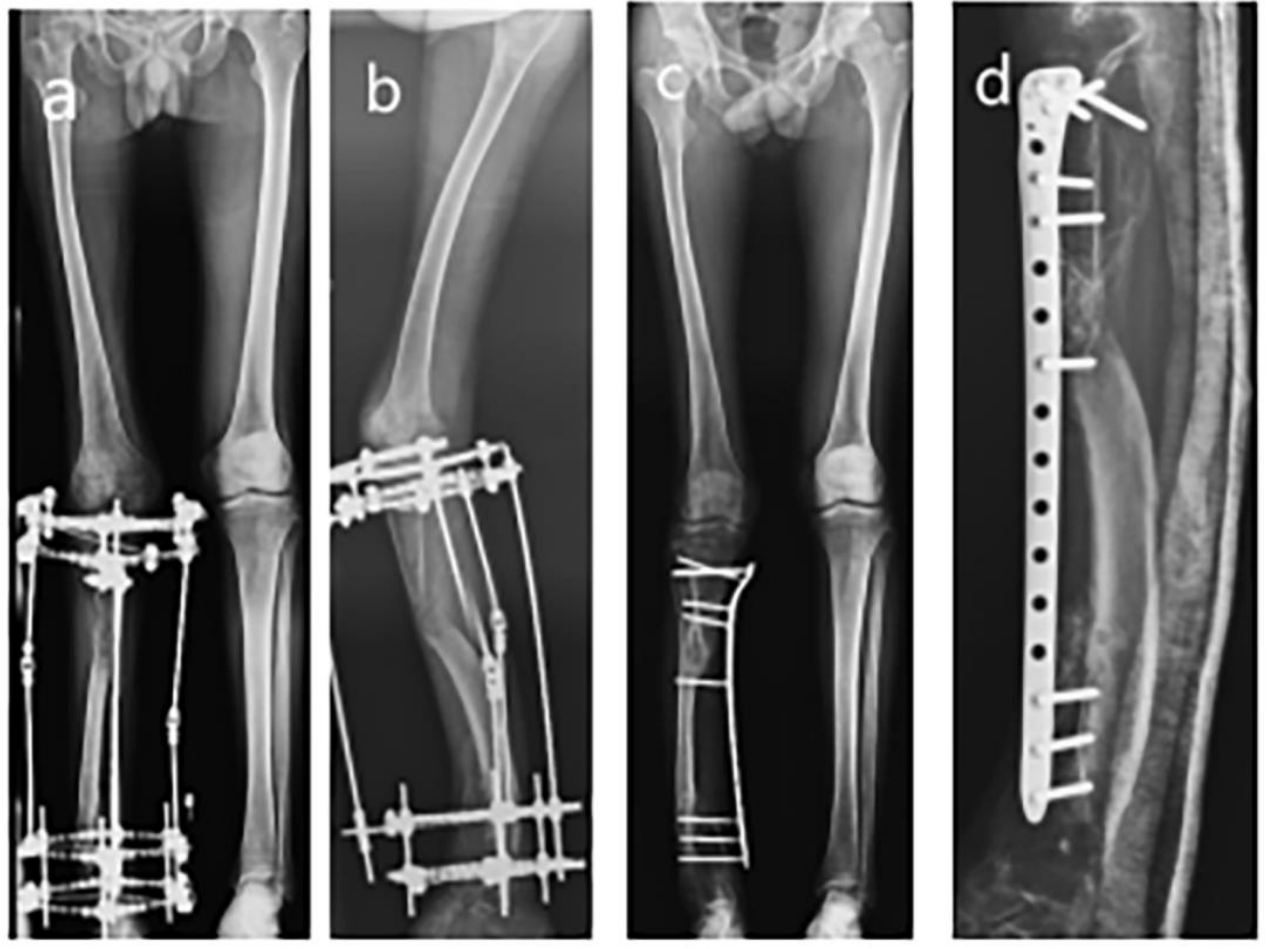
Figure 3. Removal of Ilizarov apparatus and externalized LCP. ( a ) AP view radiograph before removal of Ilizarov apparatus; ( b ) Lateral view radiograph before removal of Ilizarov apparatus; ( c ) AP view radiograph of externalized LCP fixation; ( d ) Lateral view radiograph of externalized LCP fixation.